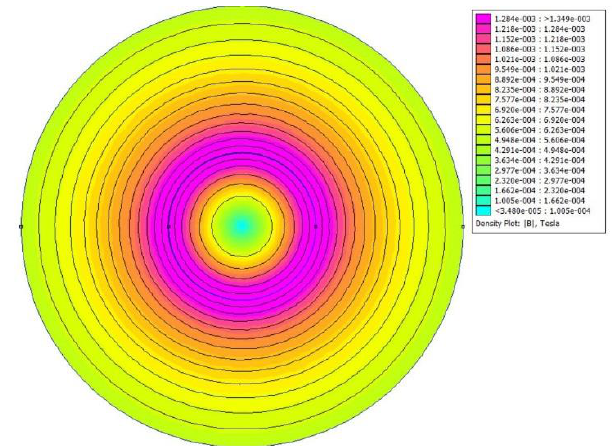
Figure 2. Simulation of the flux distribution under an electromagnetic induction (EMI) sensor .